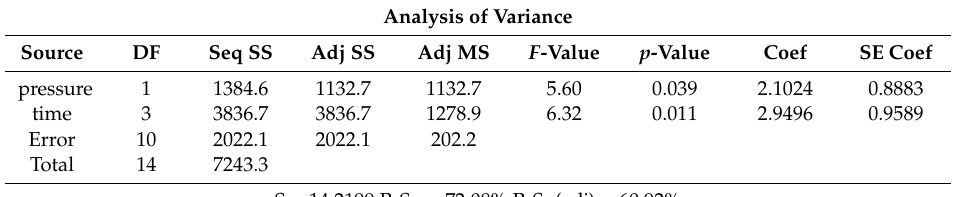
Table 3. GLM ANOVA to determine the parameter e ff ect of steam explosion on the methane yield. Analysis of